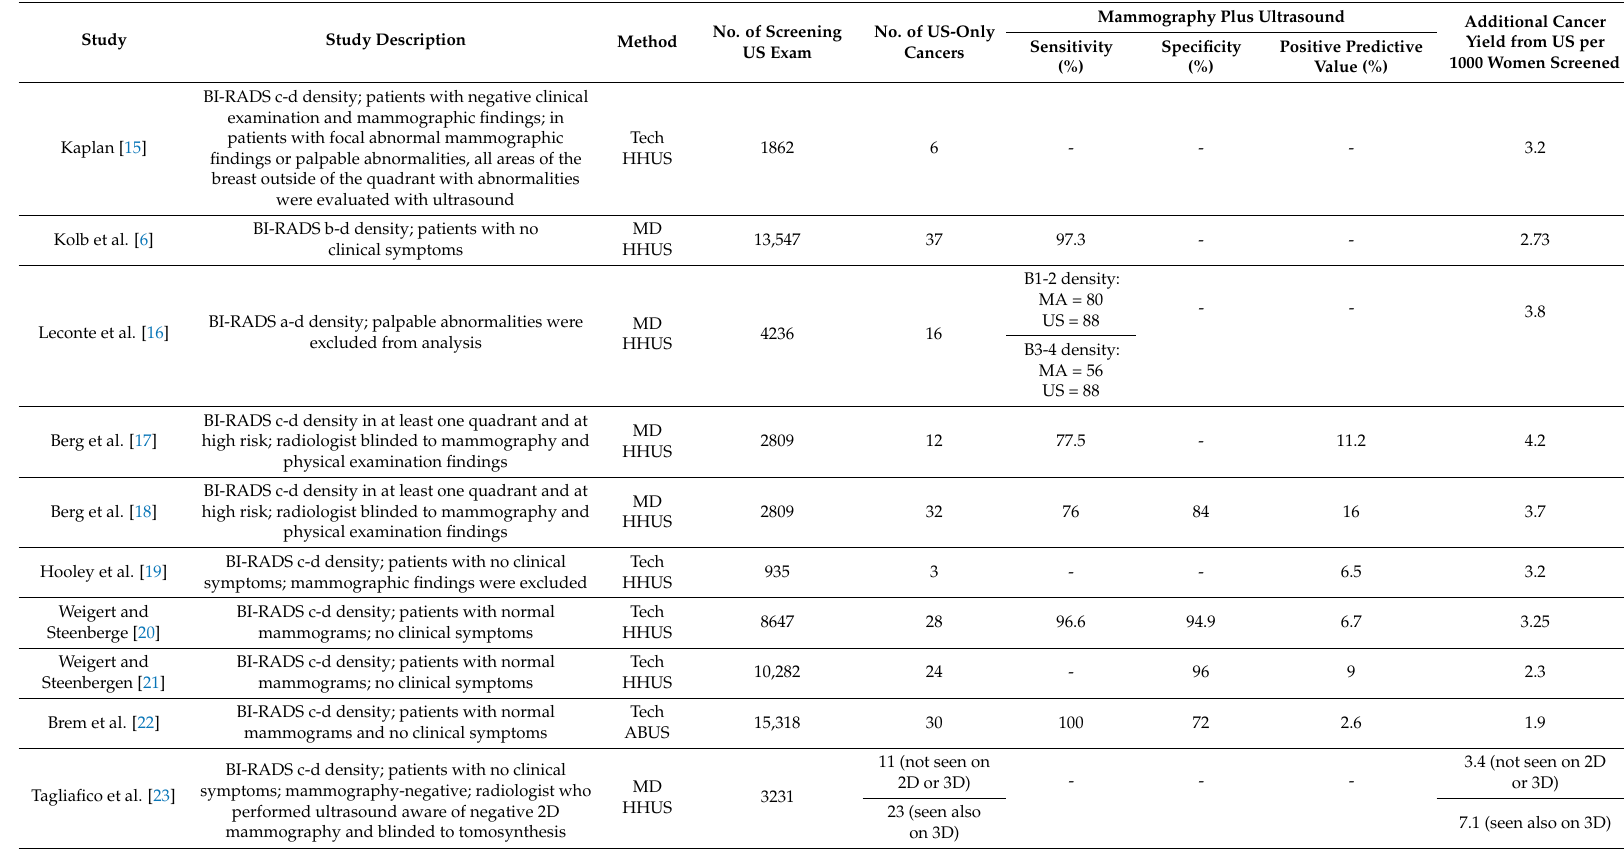
Table 2. Summary of Findings in Reviewed